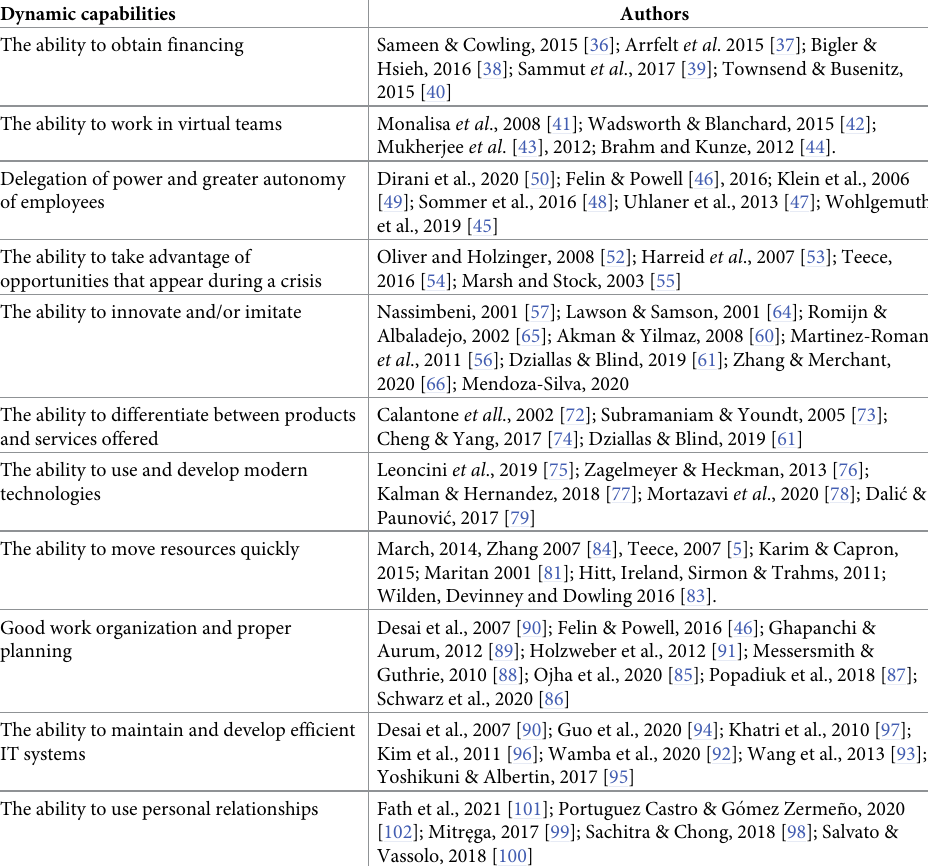
Table 1. First-order dynamic capabilities in turbulent